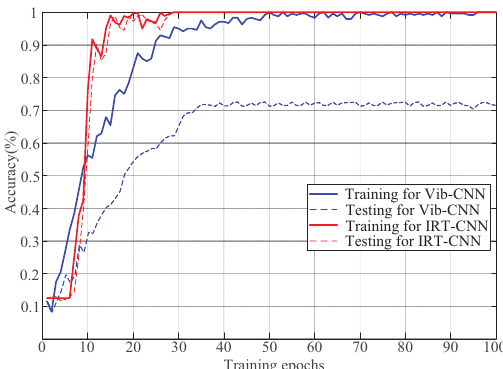
Figure 14. Training and testing performance curves in terms of overall